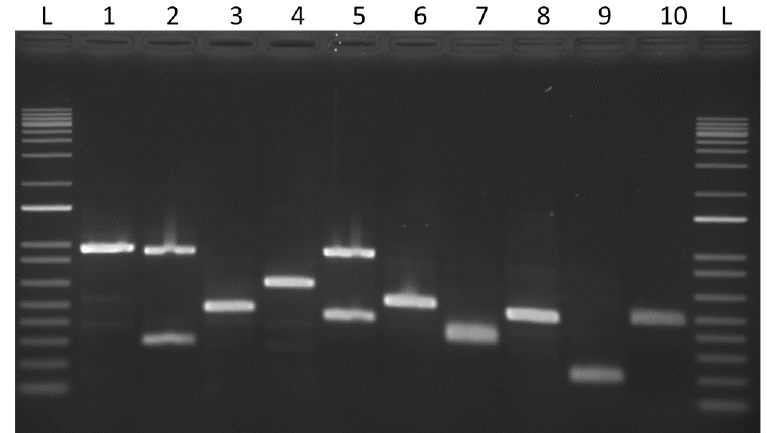
Figure 5. Vectorette PCR. An example of vectorette PCR to identify single insertions and multiple insertions. Lanes 2 and 5 show double insertions. For lanes that displayed same-sized bands, these PCR products were recovered and sequenced to rule out clonality.